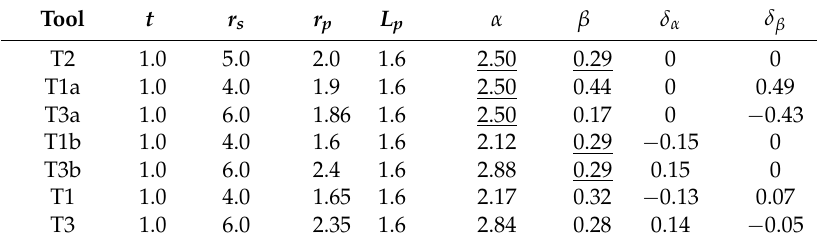
Table 1. Geometric parameters, parameters α and β , and relative deviations δ α and δ β of weld tools developed by the thermal-mechanical model (Unit: mm). Tool t r s r p L p